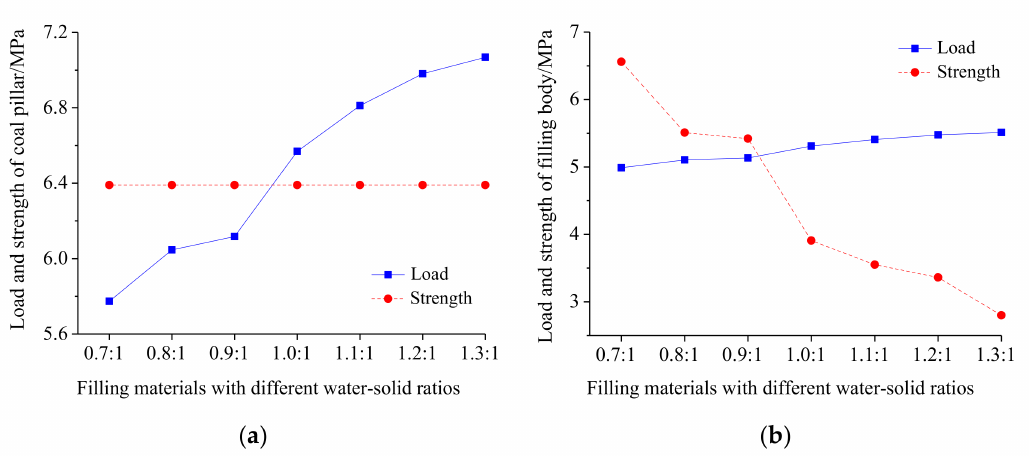
Figure 9. Strengths of coal pillars ( a ) and filling materials ( b ) and loads applied on them while using filling materials with di ff erent water–solid